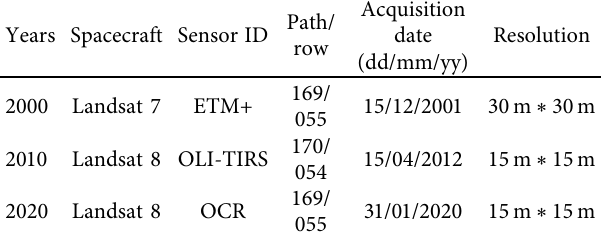
Table 3: Data from satellite imaging. Path/ Years Spacecraft Sensor ID row